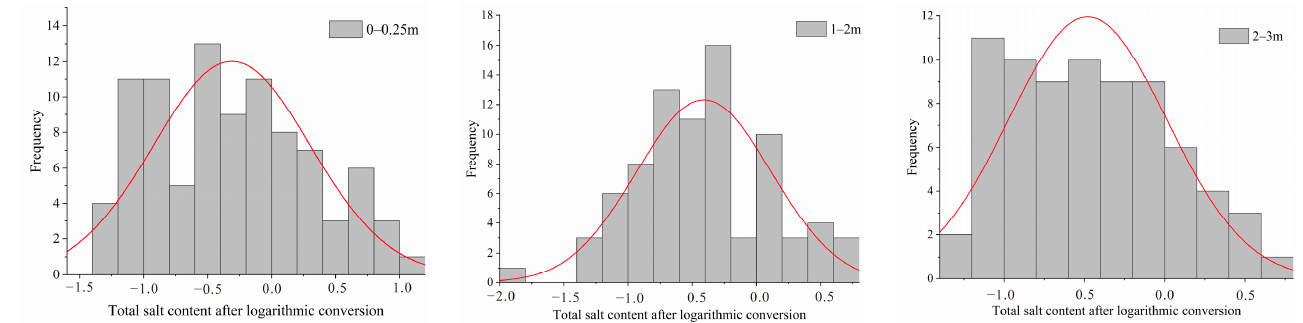
Figure 5. Histogram of frequency distribution of salt content.